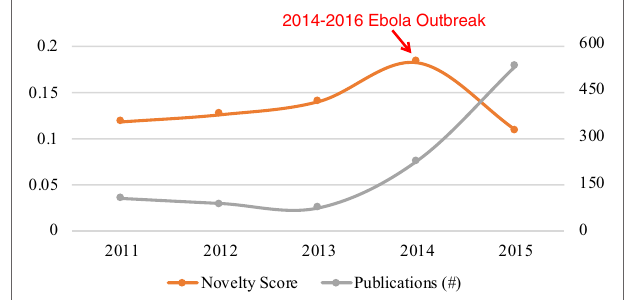
FIGURE 1 | Co-evolution of the novelty and growth of research on “Ebola Virus.”